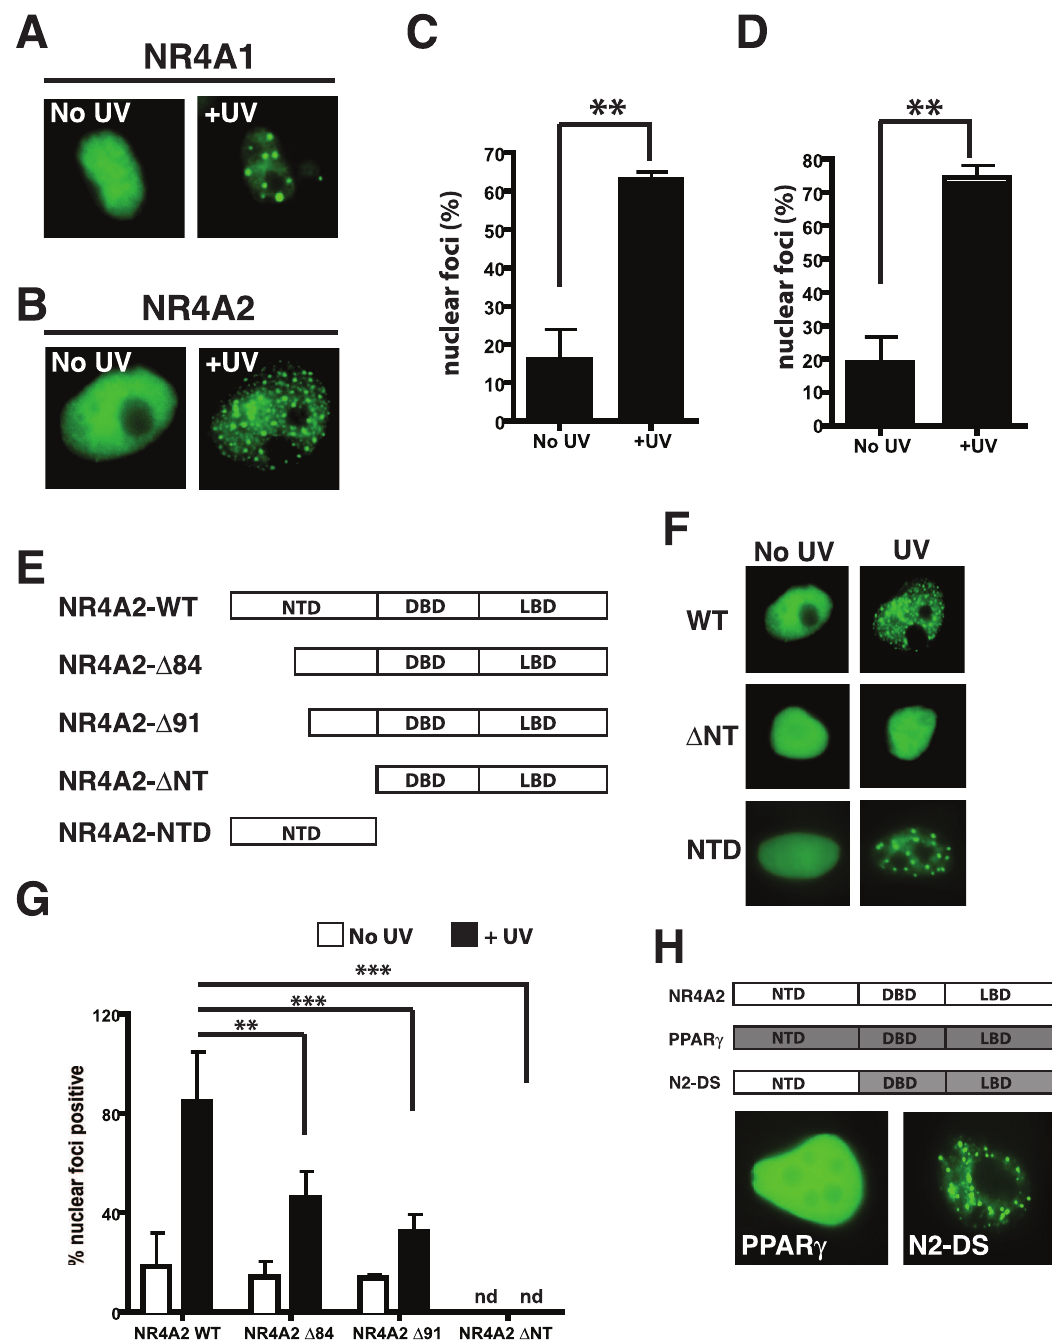
Figure 1. UVB irradiation induces NR4A nuclear foci formation. ( A–B ) MM96L cells transiently transfected with EYFP-NR4A1 ( A ) or EYFP- NR4A2 ( B ) were mock (No UV), or UVR ( + UV) treated, and fixed 4 hours post treatment. Localisation of the NR4A fusion proteins was determined by fluorescence imaging, representative cells are shown. ( C–D ) Relative quantification of UV induced NR4A nuclear foci was performed by blind scoring images as diffuse or nuclear foci positive for NR4A1 ( C ) or NR4A2 ( D ). Data represents the pooled relative percentages from at least three independent experiments. An unpaired student t-test was used to determine the statistical differences between control and UV treated cells (**p , 0.01, ***p , 0.001). ( E ) A schematic representation of the NR4A2 WT, NTD alone and sequential N-terminal deletion mutants of NR4A2 used to identify the region responsible for translocation to foci. In all cases the EYFP fluorophore is fused at to the N-terminal end of the protein. (NTD, N- terminal domain; DBD, DNA binding domain; LBD, ligand binding domain). ( F ) Representative images of nuclear localisation of EYFP-WT and D NT and NTD NR4A2 proteins following mock or UVR treatment, as indicated. ( G ) Localisation of EYFP-NR4A2 WT, D 84, D 91 and D NT proteins to nuclear foci in response to mock (white boxes) or UV irradiation (black boxes) was scored as foci positive or negative in blind analysis. Data represents the mean + / 2 SEM of three independent experiments. Statistical analysis was performed using ANOVA with a Tukeys post-test (***, p , 0.001; **, p , 0.01, ns=not significant, nd=0 foci positive nuclei detected). ( H ) Schematic representation of an NR4A2 N-terminal domain- PPAR c dominant negative-LBD chimera termed N2-DS. Lower panels show the post UVR localisation of EYFP tagged PPAR c and N2-DS chimera in the nucleus of transfected cells.